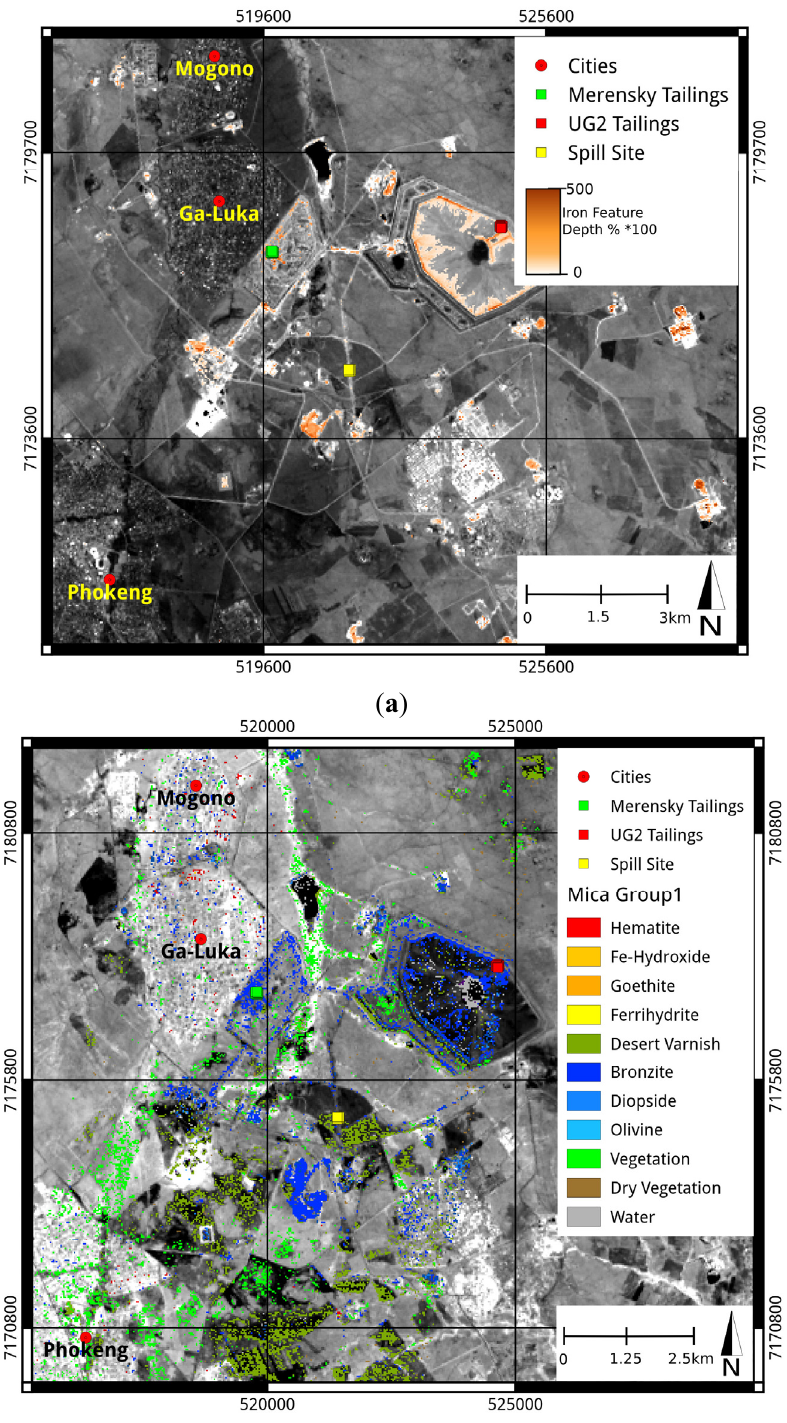
Figure 7. Iron feature depth (IFD) over the Rustenburg tailings complex calculated from OLI data overlain on the grayscale near-infrared (NIR) channel of OLI ( a ), directly below. USGS MICA Analysis from Hyperion data overlain on the gray-scaled NIR channel of OLI ( b ). Note the close match between the IFD in (a) and the iron-bearing minerals and cover types shown in (b) (bronzite, diopside and desert